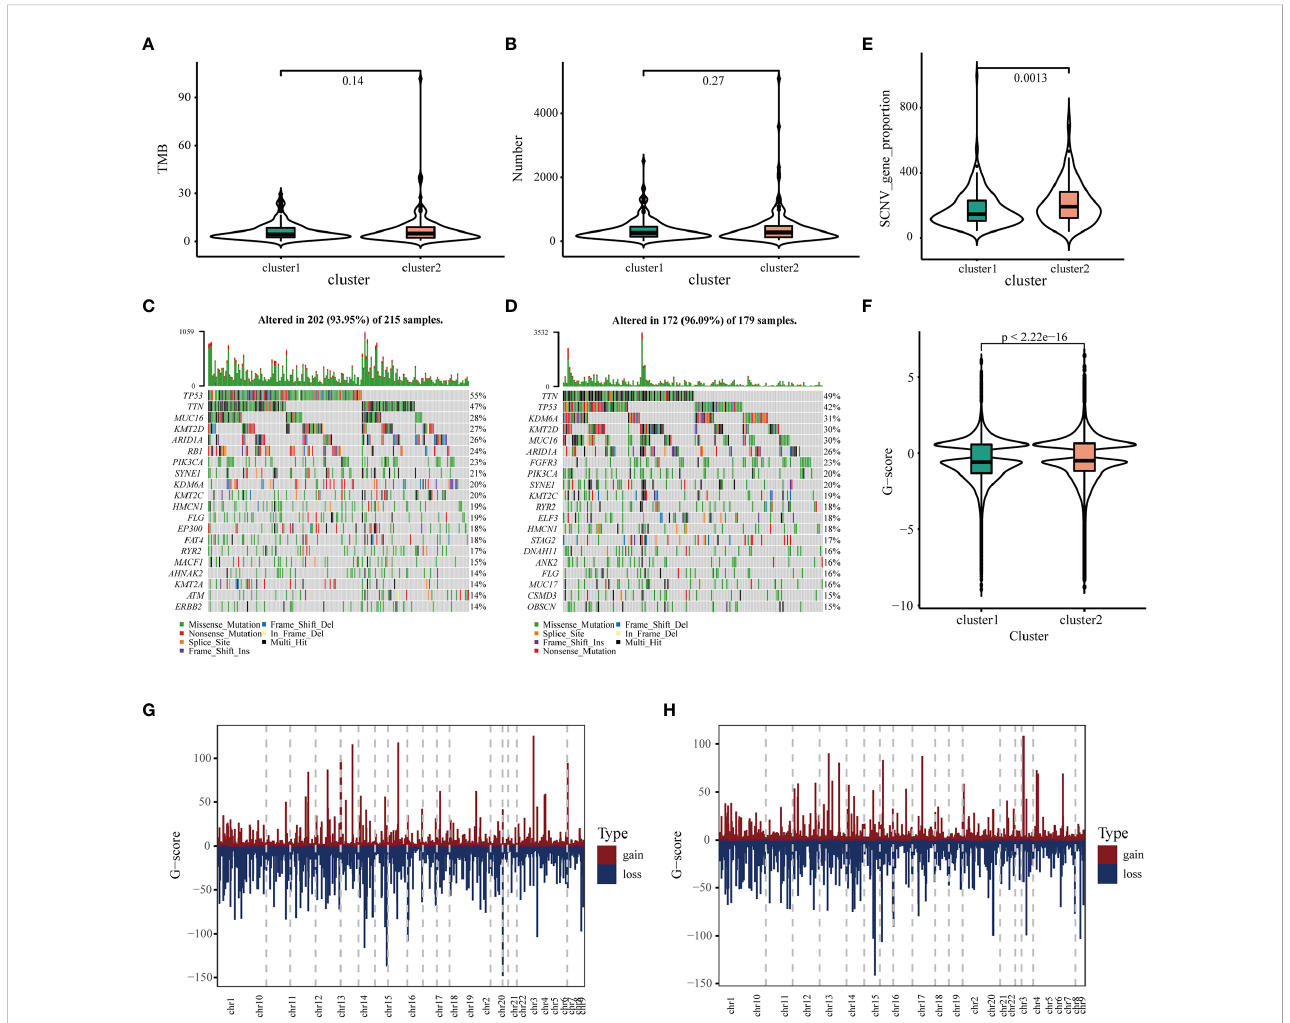
FIGURE 4 Association of immune clusters with mutation. (A) Tumor mutation burden and (B) mutation count across IC1 and IC2. Waterfall diagram of top 20 mutated genes in (C) IC1 and (D) IC2. (E) Association of immune clusters with somatic CNVs. (E, F) Association of immune clusters with G-score. (G, H) Gain or loss frequencies of CNVs across chromosomes in (G) IC1 and (H)